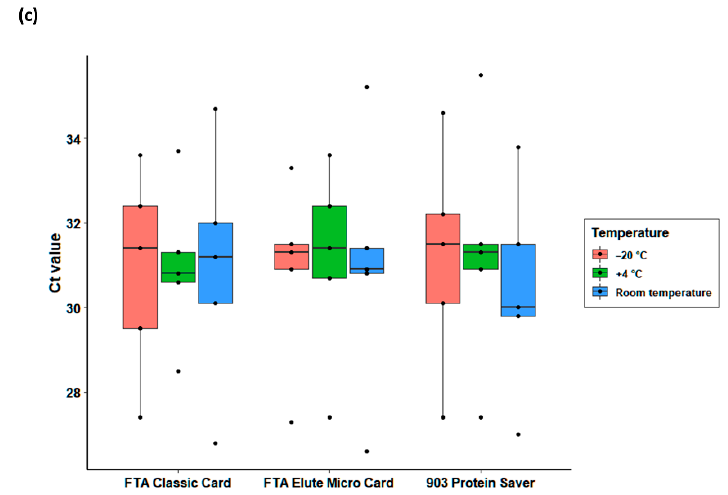
Figure 2. Box plot of cycle threshold (Ct) values generated from Giardia duodenalis isolates extracted from the three Whatman ® cards evaluated in the present study at different storage conditions. ( a ): 1 month-length storage; ( b ): 3 months-length storage; ( c ): 6 month-length storage. Horizontal thick lines within boxes represent median values Upper and lower whiskers represent the data range. Plotted dots represent outliers. Using the Tukey’s Honestly Significant Difference test as multiple post hoc comparison method, statistical significance is represented as * ( p < 0.05).